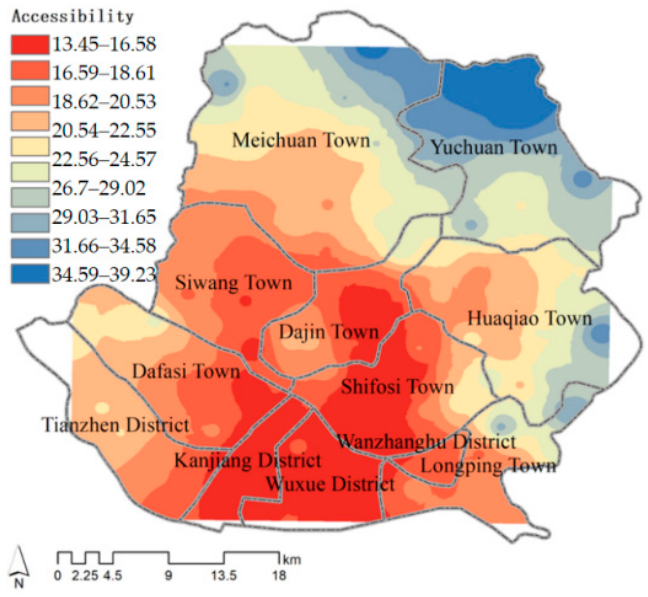
Figure 21. Accessibility analysis based on travel time after modification. Table 6. Comparison of accessibility indicators before and after modification.